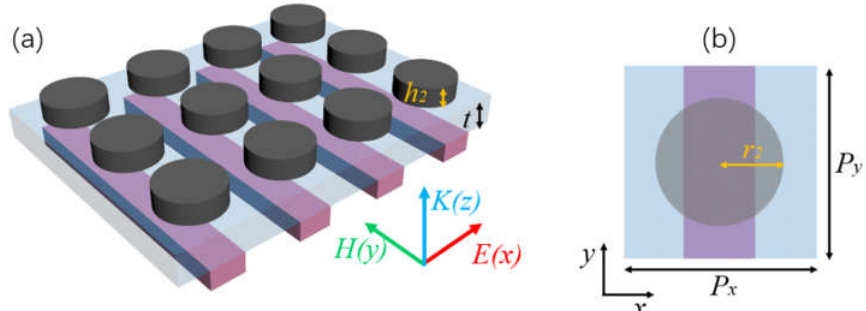
Figure 3. ( a ) Schematic diagram of a double-layer R-DMS. The 2D DMS and 1D RMS were on the top and bottom of a dielectric layer with thickness t . ( b ) Top view of the unit cell. Geometric parameters of the disk were r 2 = 328 nm and h 2 = 200 nm.